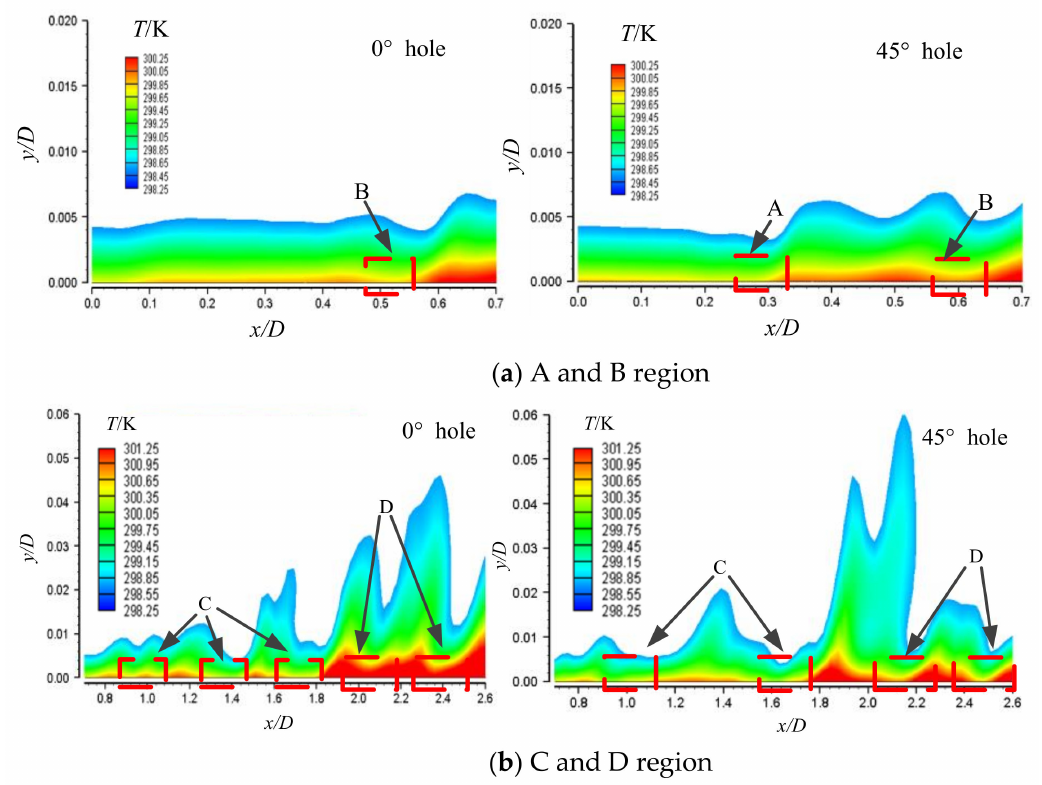
Figure 17. Temperature distribution of near-wall in the jet core and wall jet